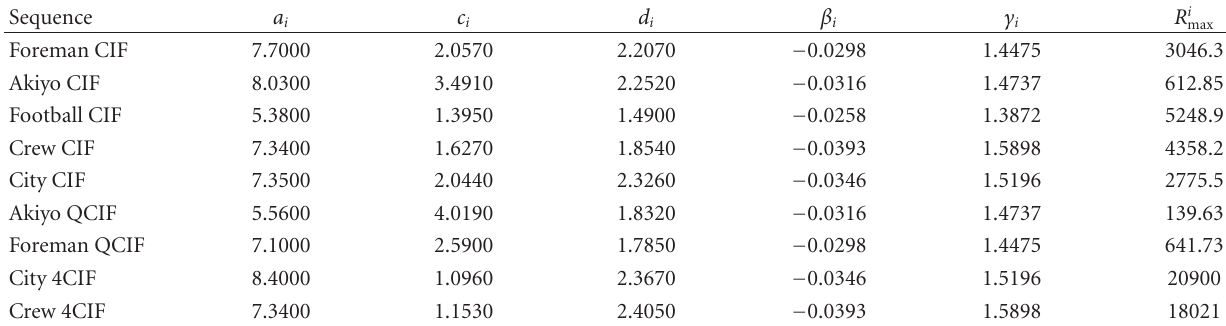
Table 1: Parameter values and R max .